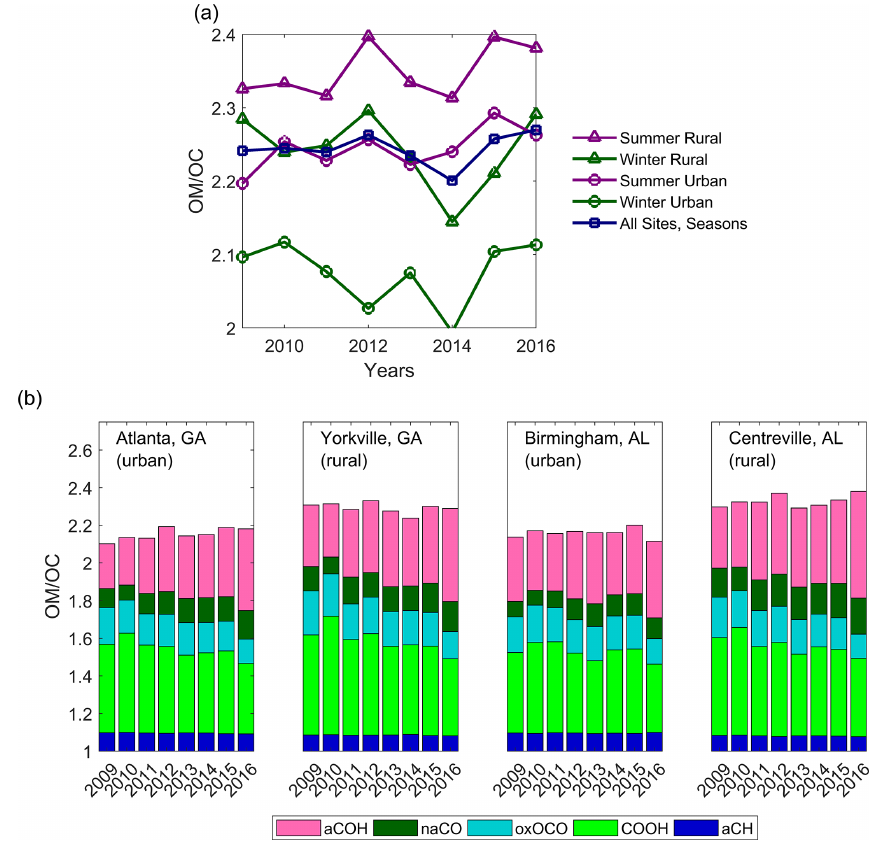
Figure 5. OM / OC, expressed as (a) seasonal median ratios at urban and rural grouped sites and (b) annual median functional group contri- butions to OM / OC ratios at each